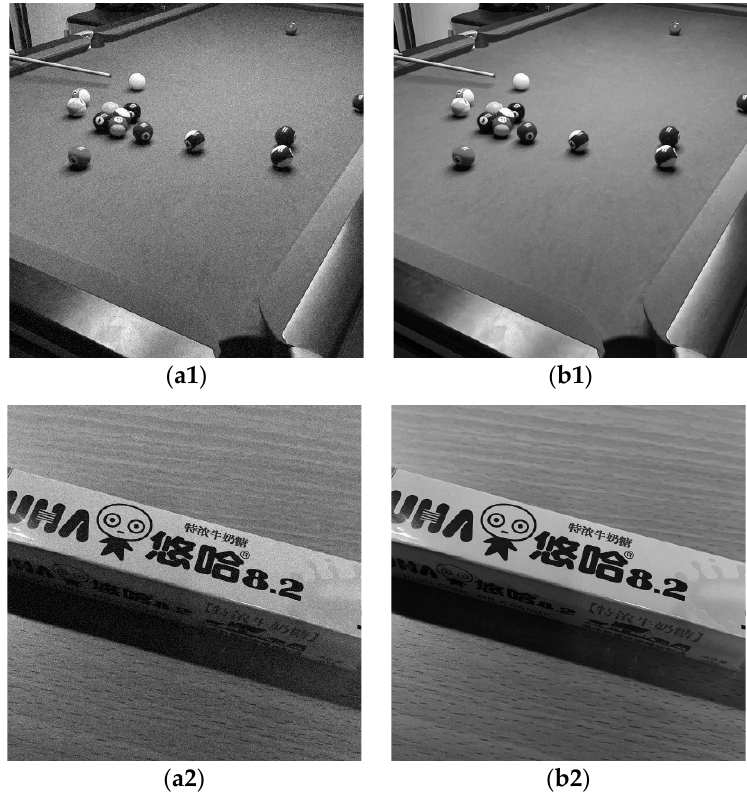
Figure 12. Image denoising comparison. ( a1 , a2 ) The original image. ( b1 , b2 ) Ours.